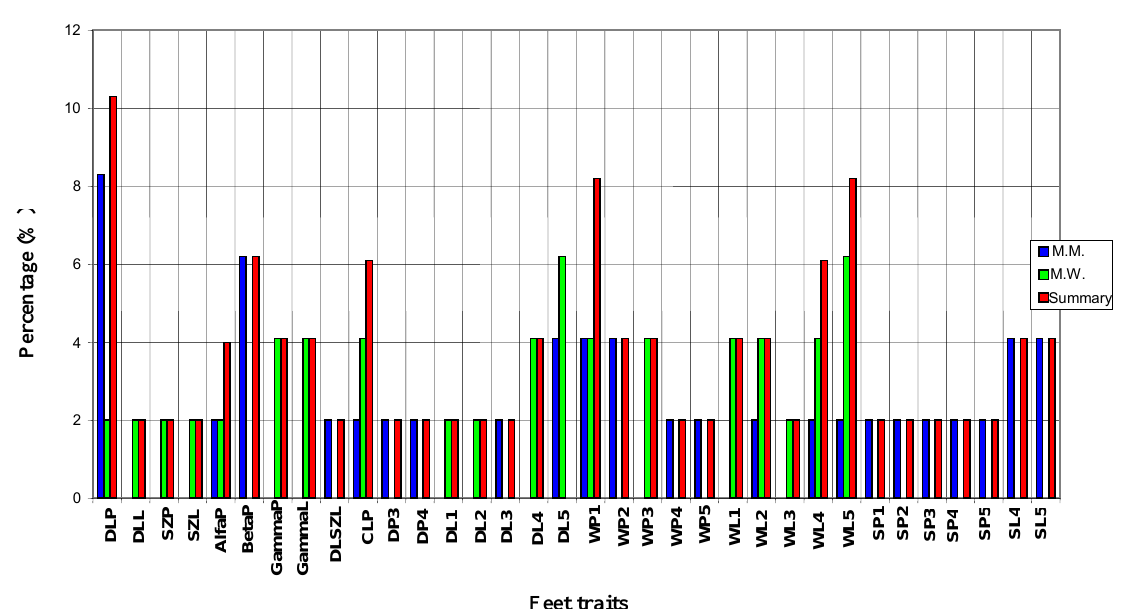
Fig. 2 Frequency of significant influence of feet traits on the complex of spine-pelvis traits in the population of boys aged 4 to 6 years from rural areas and cities (n) MM=727,